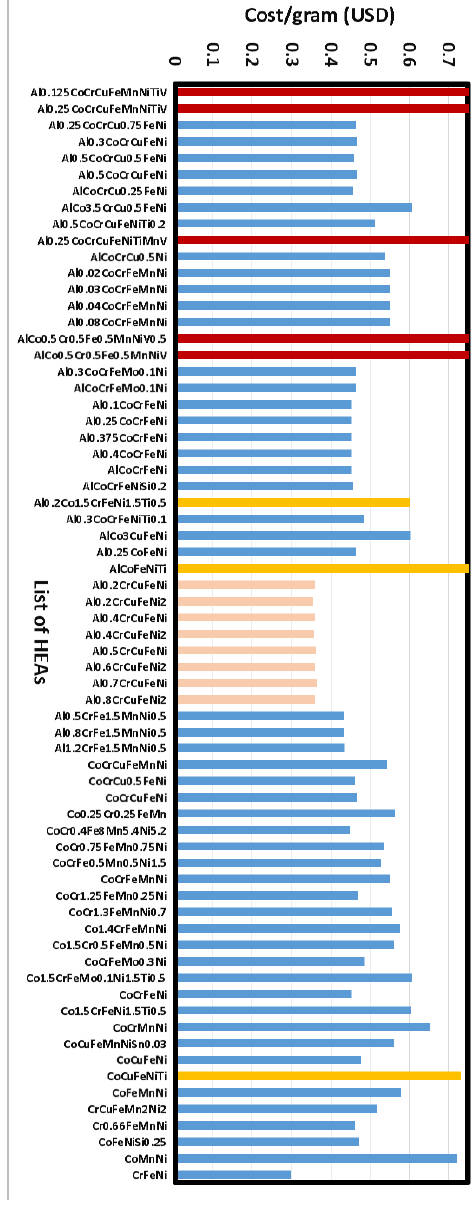
Figure A2. Estimated cost/gram of different HEAs to be used for additive manufacturing. Red color bars indicate very expensive HEAs whereas yellow bars indicate alloys with Ti. The least expensive alloys are shown in pink bars.